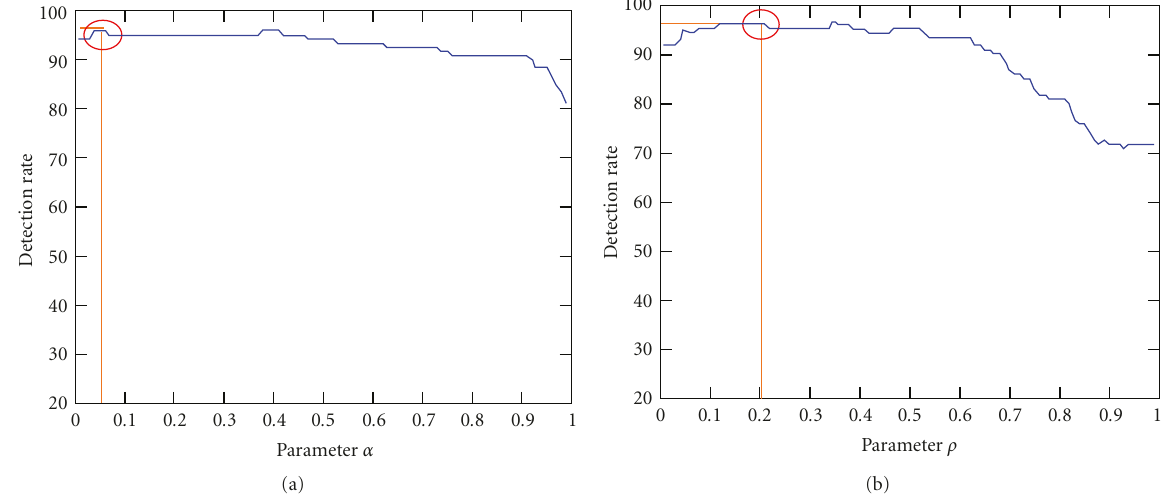
Figure 14: Detection rate, for (a) the parameter α and (b) the parameter ρ .